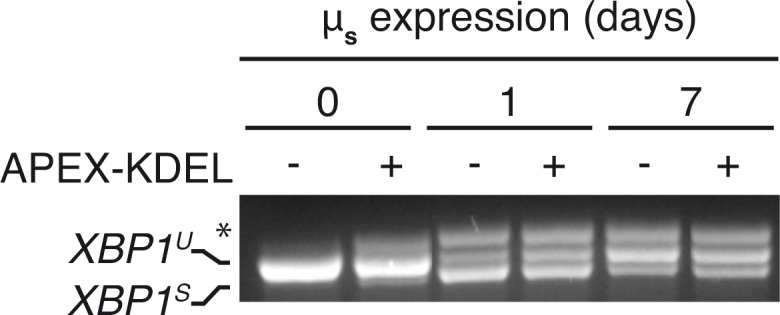
APEX-KDEL expression hardly interferes with µs-driven UPR.HeLa-µs cells expressing APEX-KDEL induced at low levels with 100 nM Dox for 2 days (+) or not (–) were induced with 0.5 nM Mif to express µs for the indicated times (days), and XBP1 mRNA splicing was assessed as in Figure 1A.